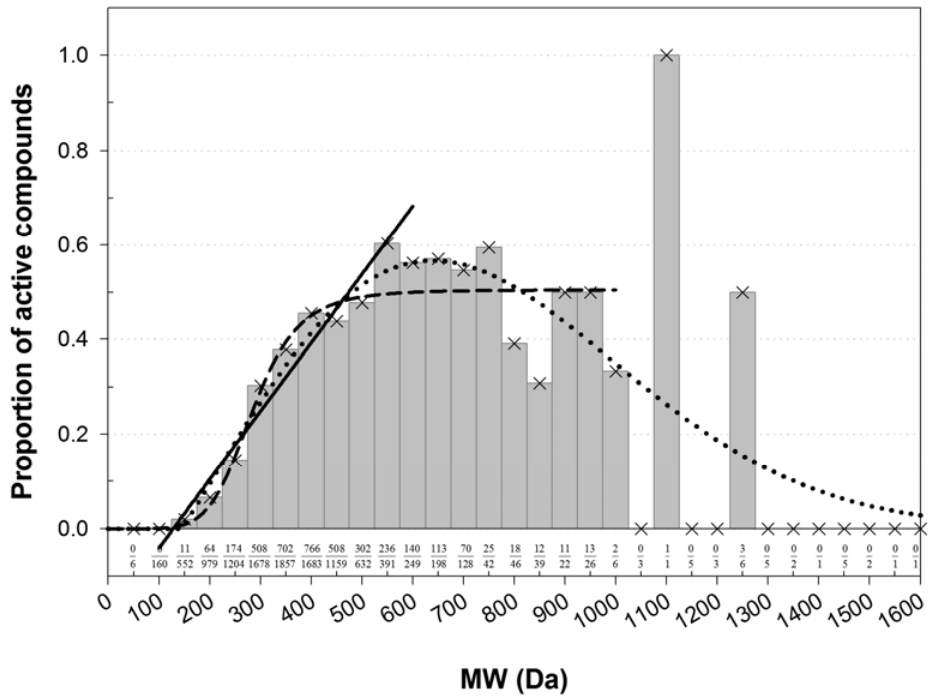
Figure 1. Normalized histogram of MW of compounds active in AID 884. The number of active compounds in each bin was normalized by the total number of active and inactive compounds in that bin. The proportions of active compounds are labeled at the bottom. The histogram shape was fitted with functions from the bell-shaped and sigmoid families and with a linear function. In the each family, only the best fit was retained. A fit with a four-parameter Weibull function (as implemented in the SigmaPlot ® software; a = 0.5670, b = 686.7269, c = 2.0494, x = 639.5385) was carried out on the entire domain of MW, 0 r 2 = 0.5837. A fit with the logistic function ( y = 0.5047/[1 + (285.1/ x ) 6.266 ]) was carried out for MW ≤ 950 Da, r 2 = 0.8970. A line ( y = 0.001437 x − 0.1825) was fitted to the bins in the range 150–550 Da, r 2 = 0.9479. The fitted shapes intersected at about the same point of 450 Da, which was taken as a threshold separating the MW range in a low-MW band that was depleted with active compounds and a high-MW band that was enriched with active